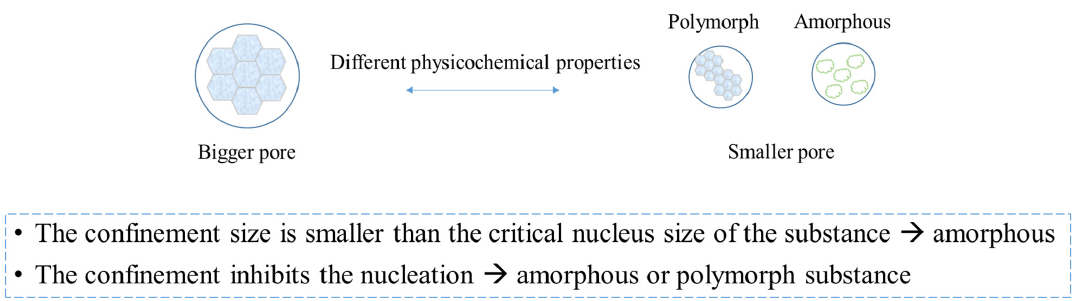
Figure 7. The concept of confinement and the relationship between confinement and